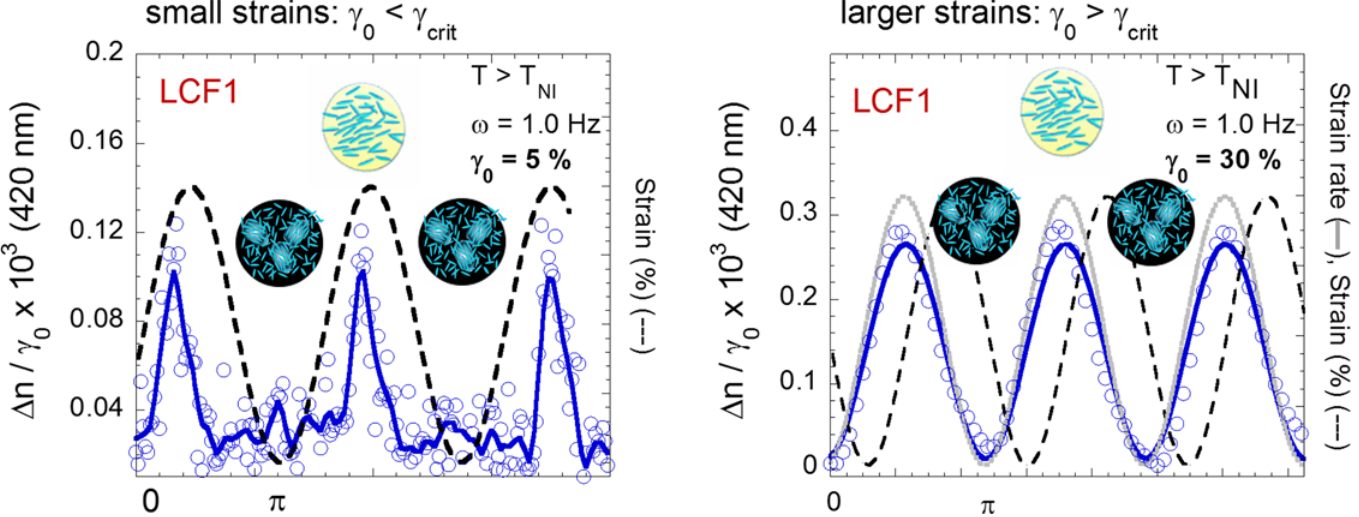
Fig 2. A mechanical oscillatory excitation at low frequency ( ω = 1.0Hz) orients the pretransitional fluctuations in the isotropic phase (T-T NI = + 0.5°C) and creates a reversible and defect-free birefringent signal (sample: LCF1, blue circles ◯ : sine model fit/smoothing of data points: continuous line, ▬▬ ). The birefringence values are normalized by the applied strain amplitude. (a) At small strain amplitude ( γ 0 = 5%), the optical signal is in- phase with the strain (black dashed line, - - -). ( b ) At larger strain amplitudes (here γ 0 = 70%), the optical signal is synchronized with the strain-rate (continuous grey line, ▬▬ ).